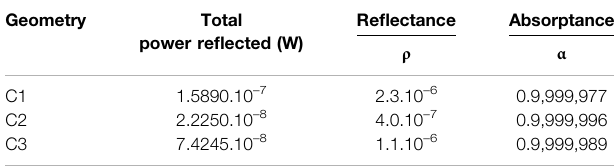
TABLE 1 | Simulated absorptance for three cavities.